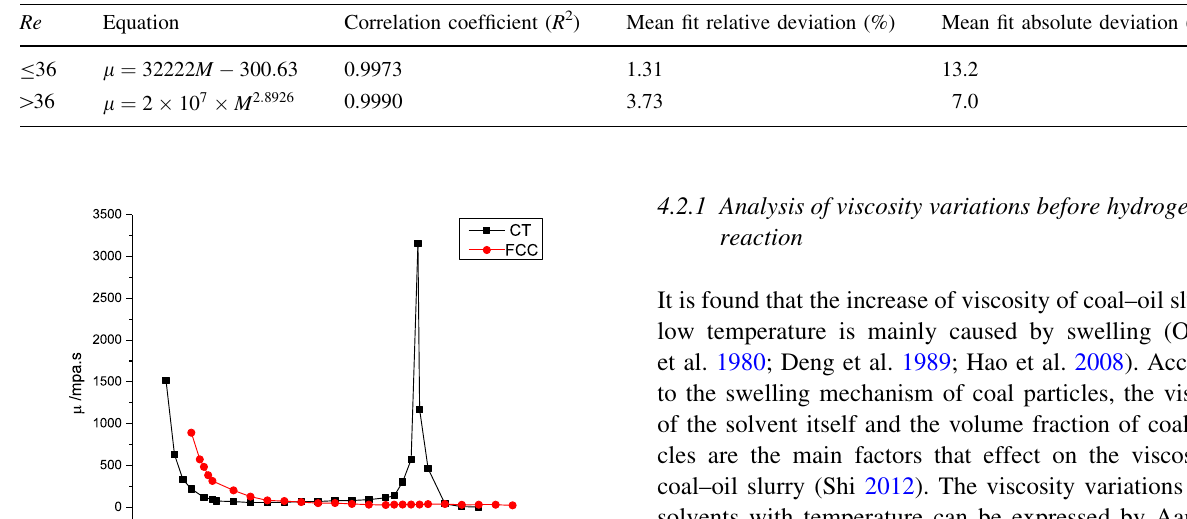
Table 3 The viscosity-torque correlations at 400 r/min